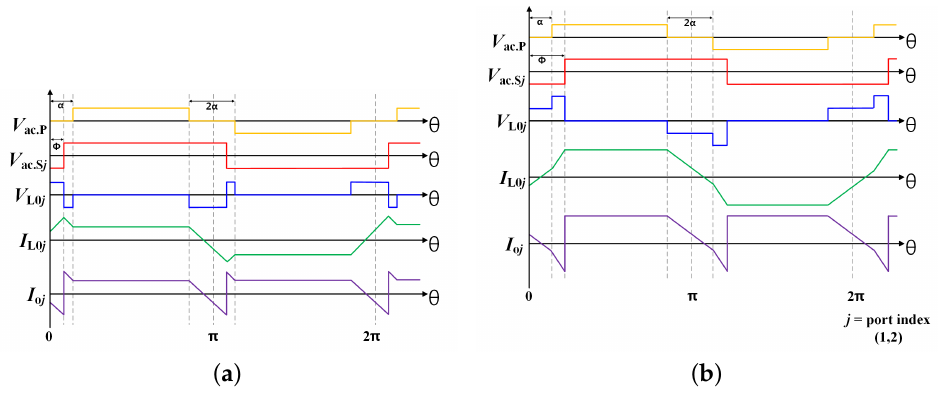
Figure 5. Theoretical waveforms of the 2-port DC/DC converter: ( a ) Case I (0 ≤ φ 0 j ≤ α ); ( b ) Case II ( α < φ 0 j ≤ π